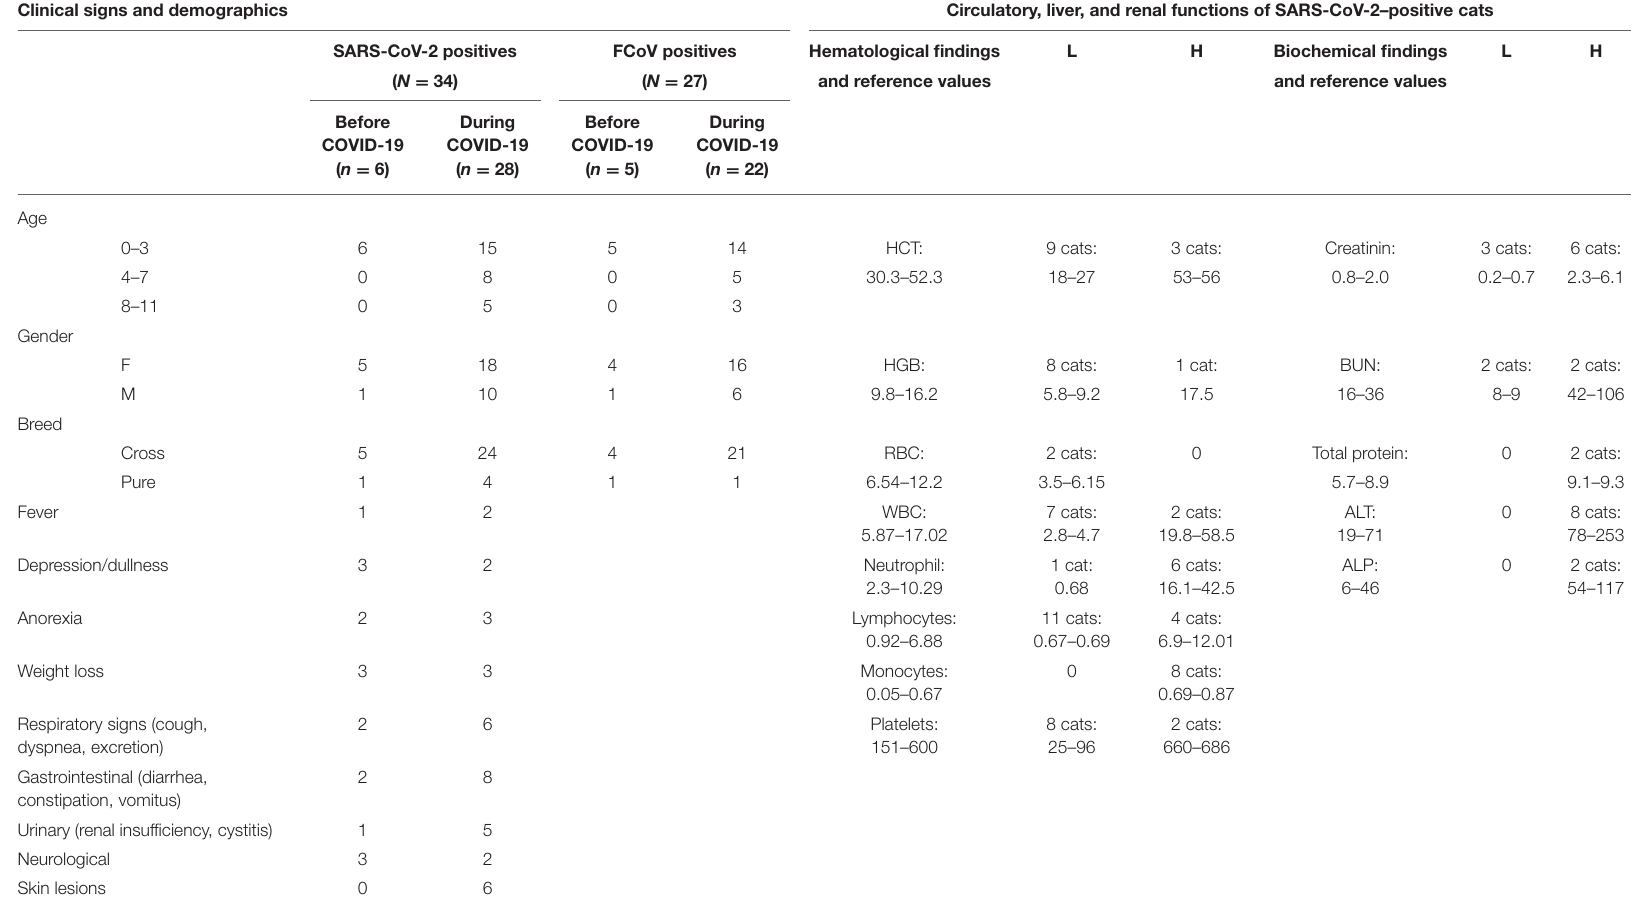
TABLE 2 | Demographics, clinical, hematological, and biochemical findings in SARS-CoV-2 seropositive cats . Clinical signs and